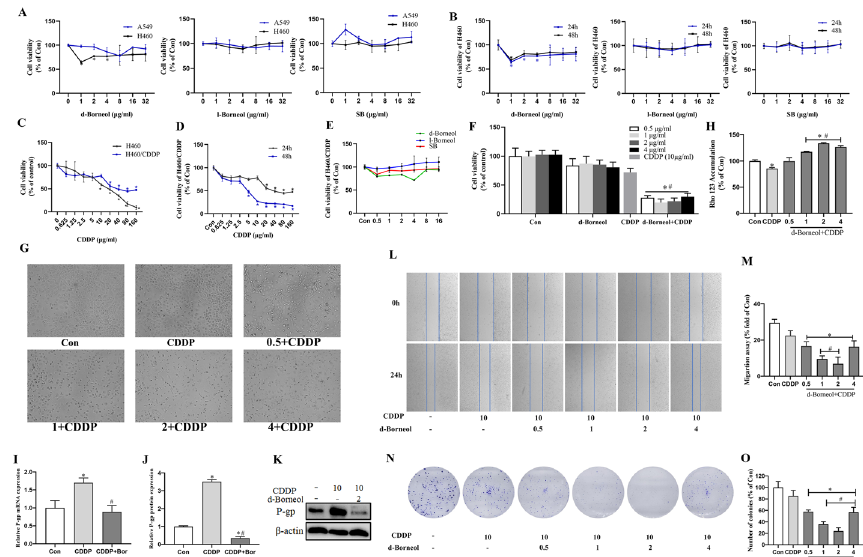
Fig. 1 Cell viability of different NSCLC cells treated with three borneol forms and cotreatment with d-borneol and CDDP, and effect on cell proliferation, P-gp function, and cell migration in H460/CDDP cells. A A549 and H460 cells cultured with different concentrations of d-borneol, l-borneol, and SB for 24 h; B H460 was treated with d-borneol, l-borneol, and SB for 24 h and 48 h, and cell viability was determined by MTT; C cell viability of H460 and H460/CDDP cells treated with different concentrations of CDDP for 24 h; D cell viability of CDDP on H460/CDDP cells for 24 h and 48 h; E cytotoxicity of the three borneol forms on H460/CDDP cells; F , G cell viability ( F ) and cell morphology ( G ) of H460/CDDP cells treated with CDDP (10 μg/ml), or d-borneol (0.5, 1, 2, and 4 μg/ml) CDDP (10 μg/ml) for 24 h; H determination of P-gp function after treatment with CDDP, CDDP + plus d-borneol with different concentrations for 24 h; I – K mRNA expression ( I ) and protein expression ( J , K ) of P-gp; L , M cell migration of H460/CDDP cells; N representative photographs showing colony formation after CDDP cotreatment with d-borneol in H460/CDDP cells; O calculation of statistical differences. All data are presented as mean SD ( n 3, * P < 0.05, compared with Con; # P < 0.05, compared with CDDP ± =